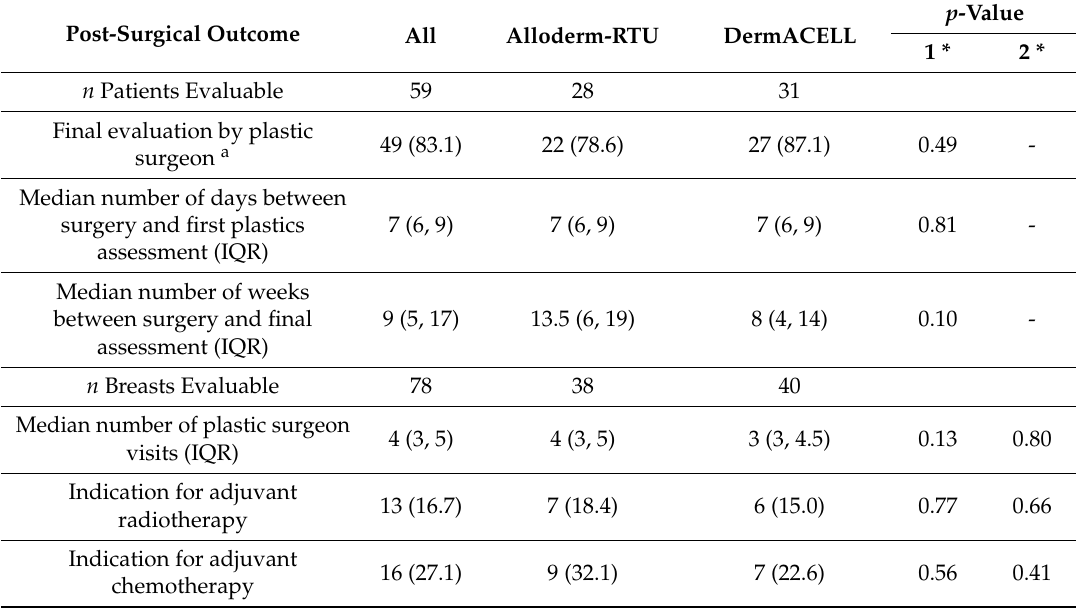
Table 4. Post-surgical treatment and follow up. All values are number (percentage) unless otherwise